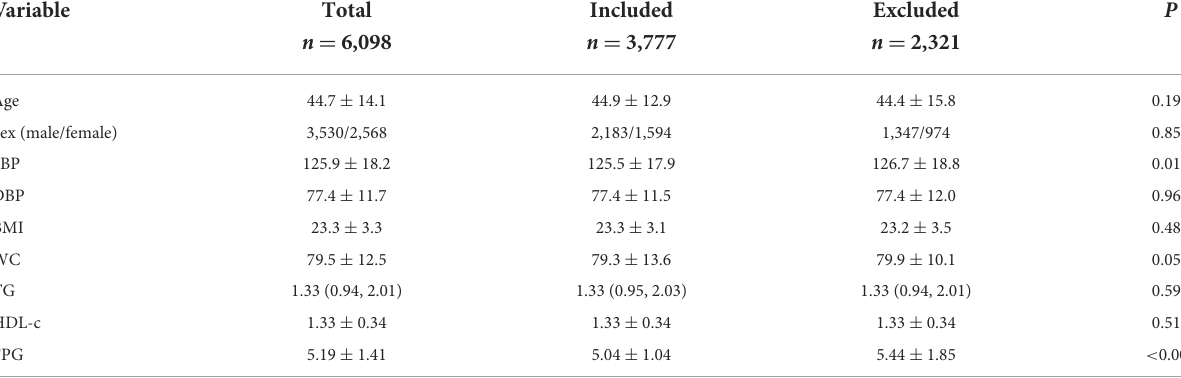
TABLE 1 Comparison of characteristics between included and excluded subjects at